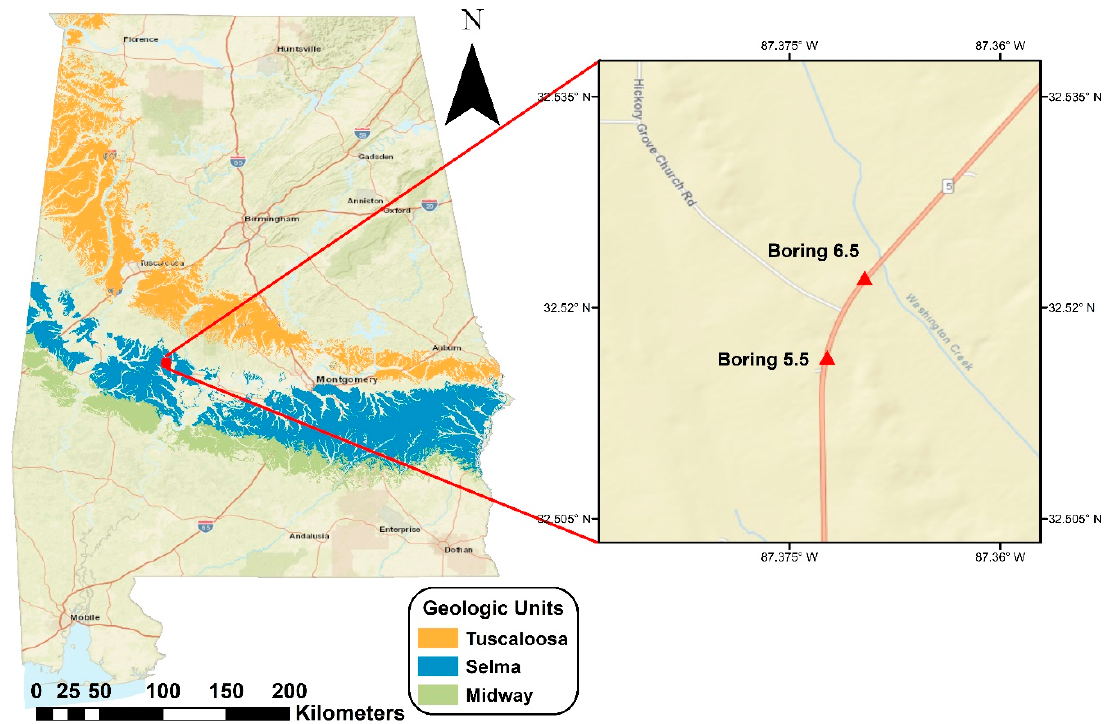
Figure 1. Locations of geologic units containing the high plasticity Prairie clays (after [4]) and the location of the research site and borings examined in the current study.